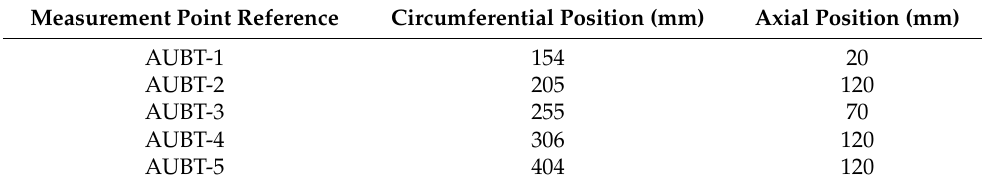
Table 5. Coordinates of acquisition points for AUBT measurements.